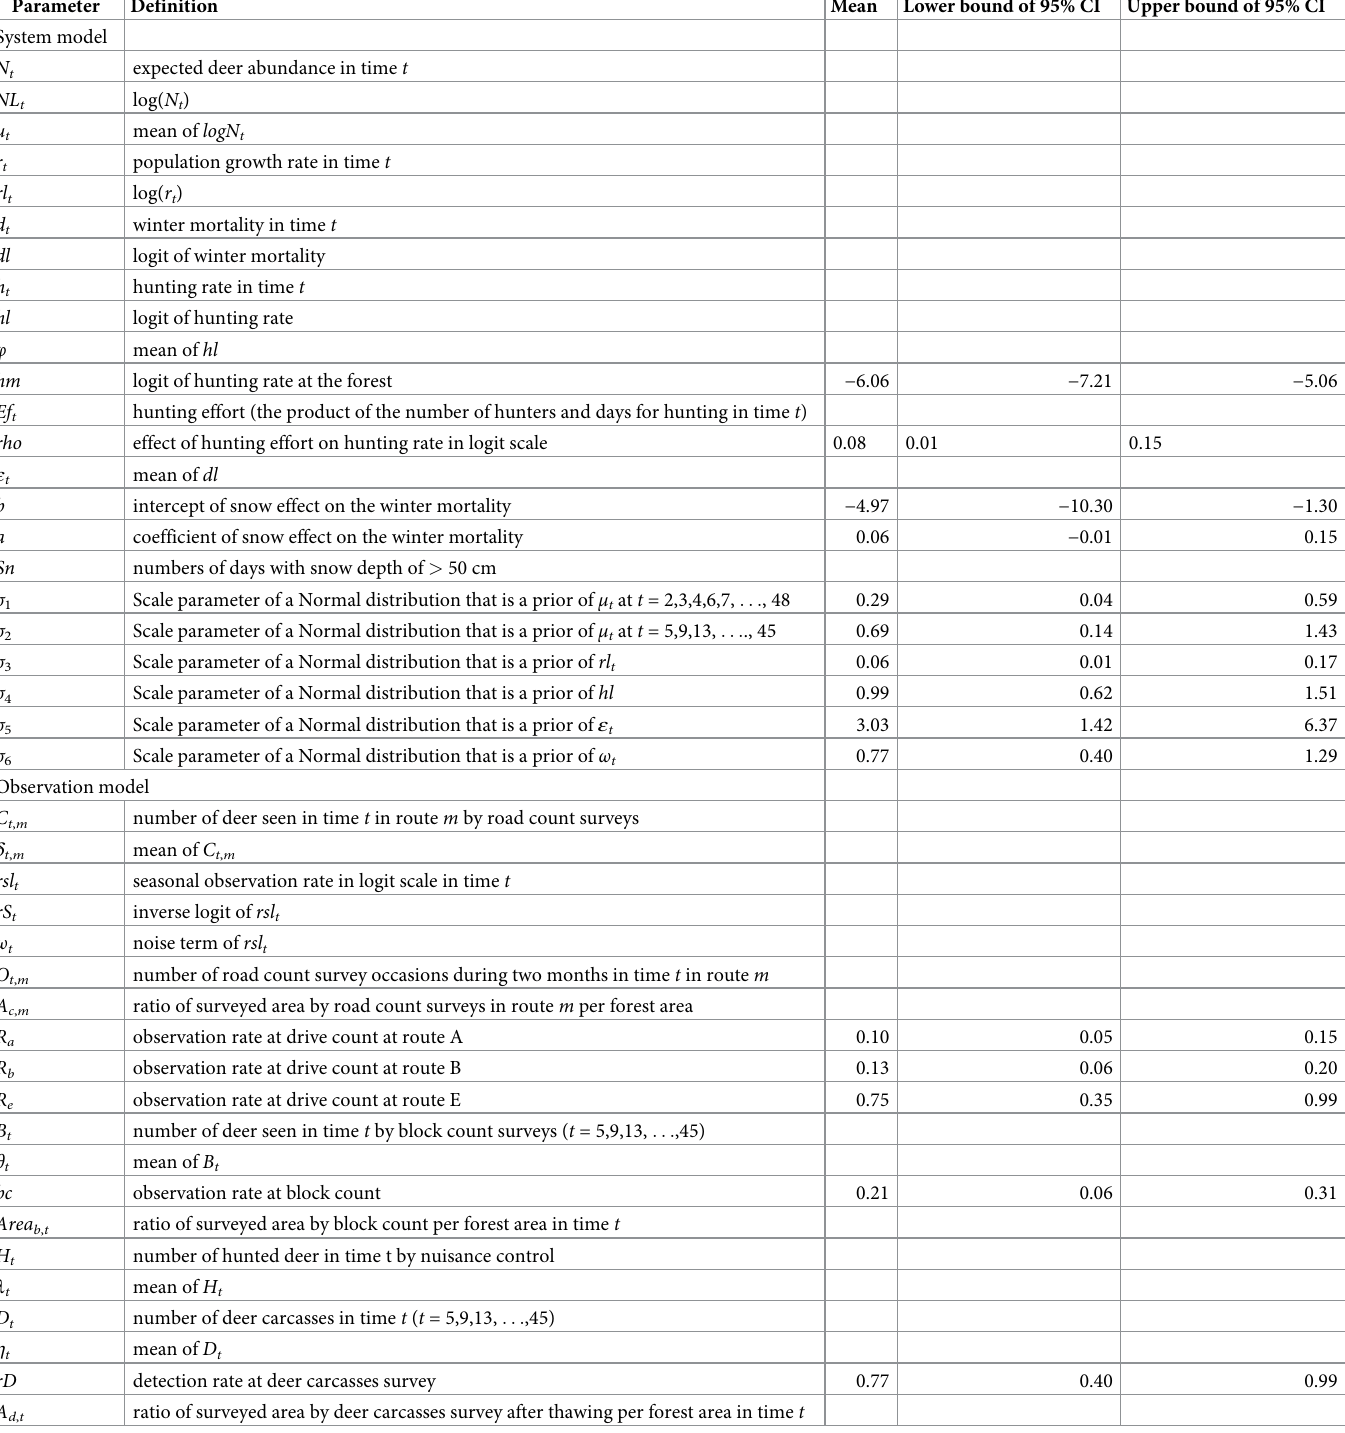
Table 3. Data and parameters designed to estimate deer abundances from multiple abundance indices and posterior summaries of coefficients from the model.